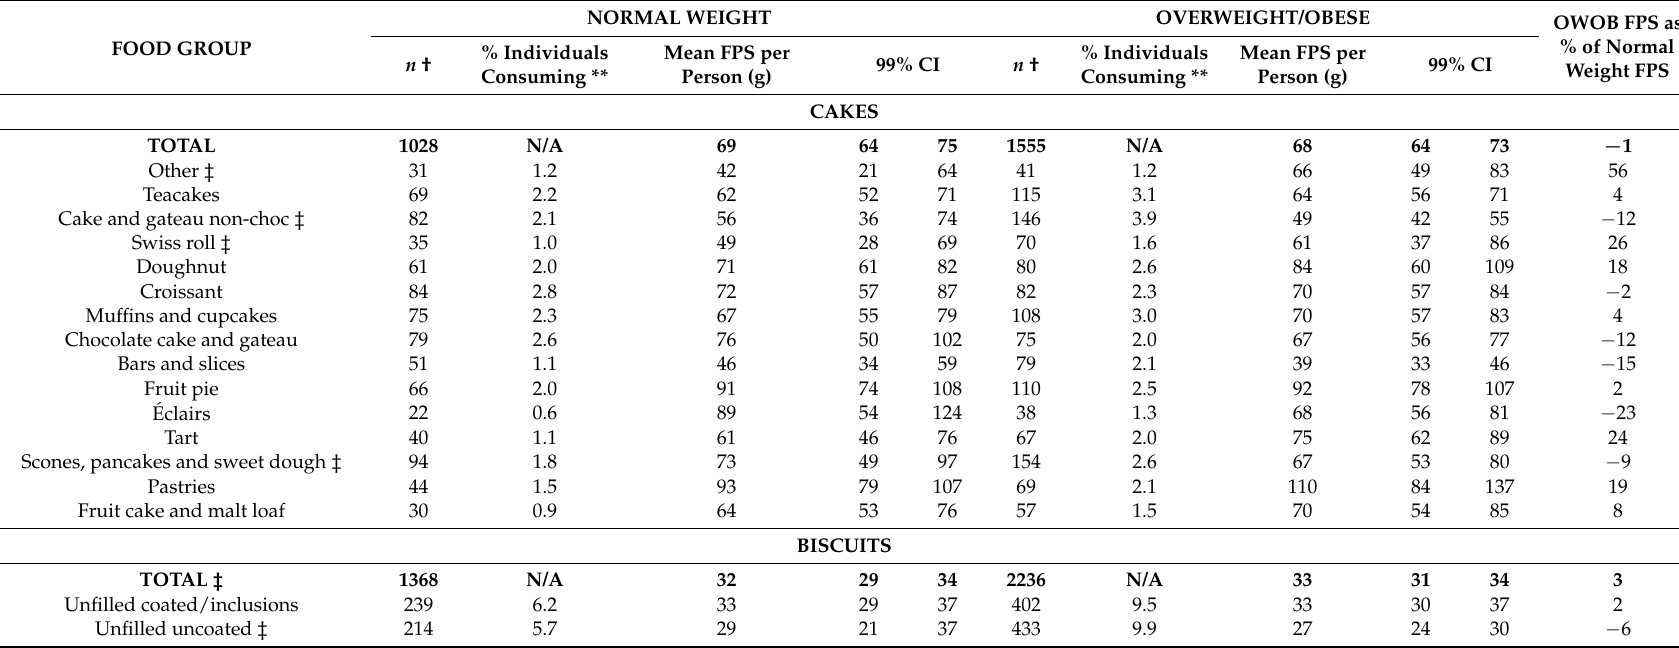
Table 3. Mean portion size of energy-dense foods by BMI status for consumers aged 19–64 years in the UK NDNS